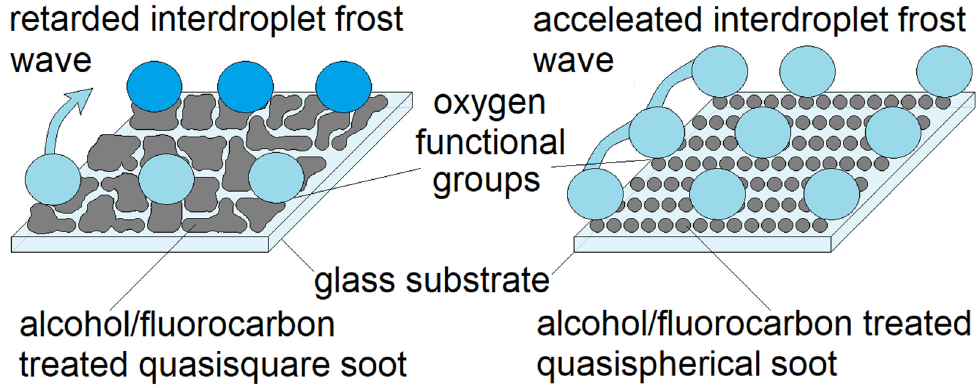
Figure 5. Delaying the interdroplet ice bridging using super-nonwettable carbon soot coatings. The opaque blue and sky blue droplets represent, the frozen and unfrozen subcooled condensates, respectively. The quasisquares ( left side ) and spheres ( right side ) denote the surface morphology of the soot. The lines below the frozen droplets aim to depict the oxygen functional groups serving as ice nucleation (active) sites. The abundance of active sites on the quasispherical soot ( right side ) accelerates the freezing events and the velocity of the interdroplet freezing [37].